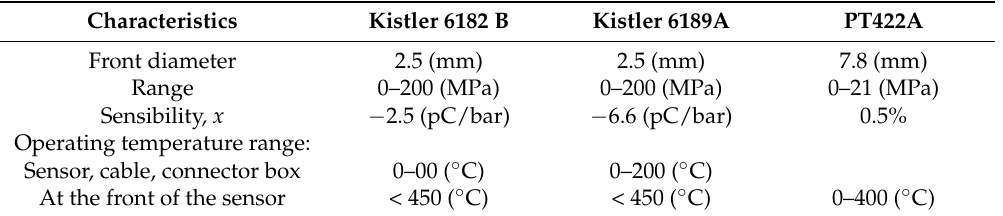
Table 1. Characteristics of the melt pressure transducers.